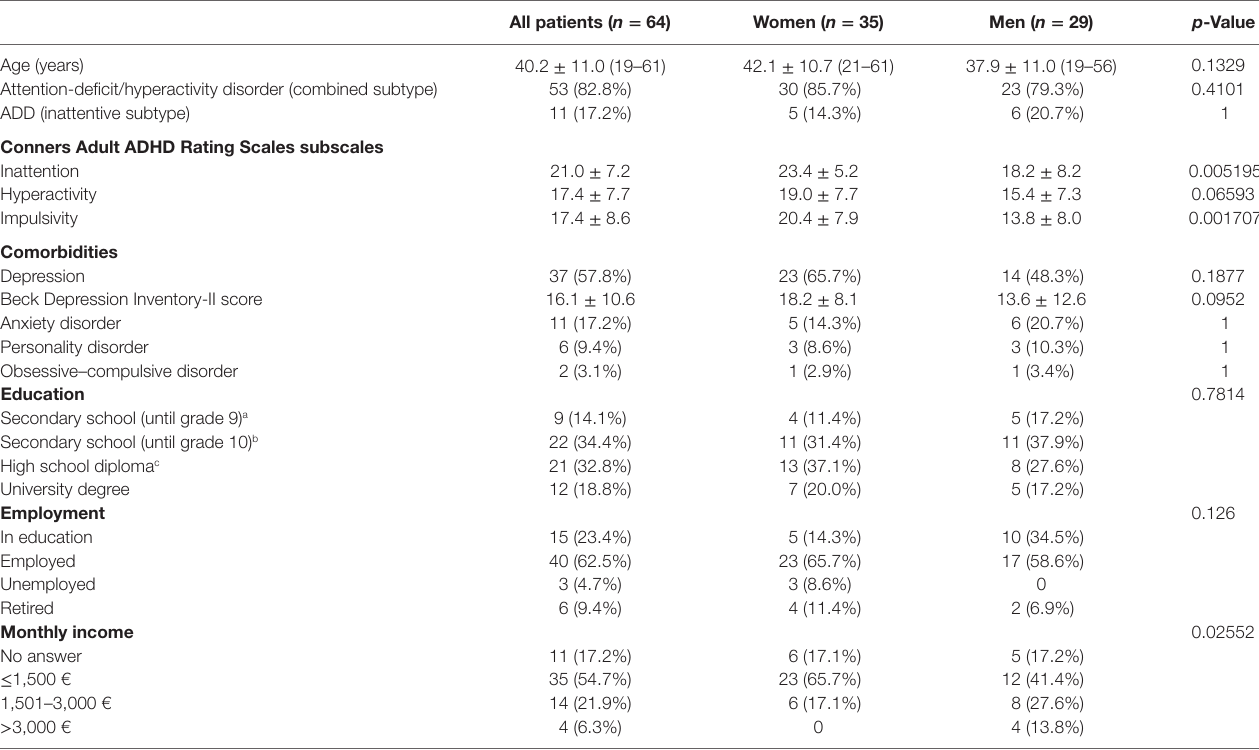
TaBle 1 | Demographics.